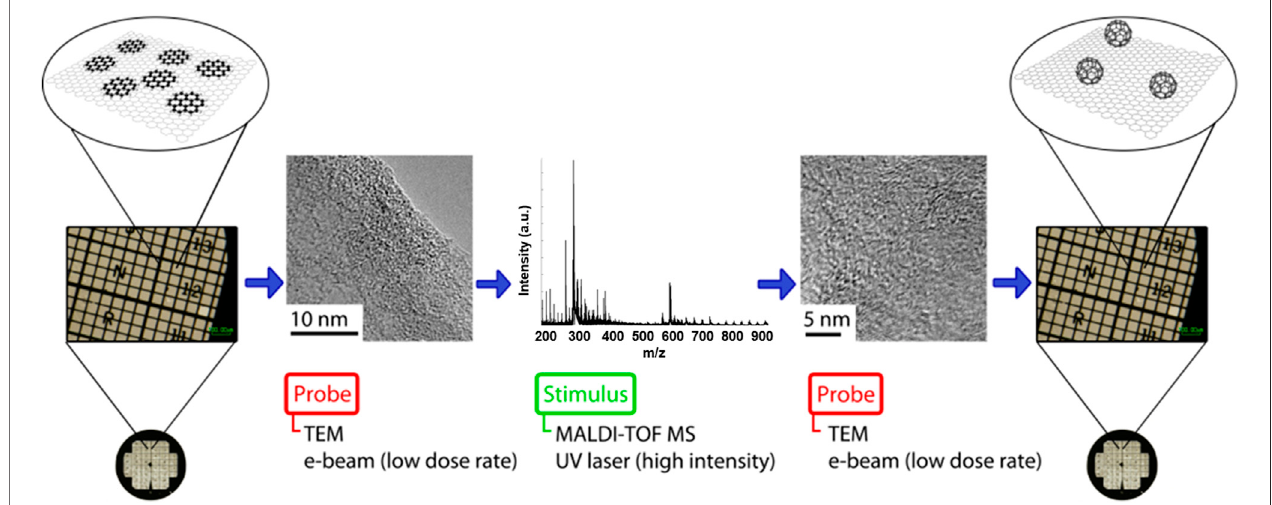
FIGURE 4 | Schematic illustration of the “ probe-stimulus-probe ” format in which an area of coronene deposited on a TEM grid is characterized using low-dose TEM, and then irradiated using the UV laser of MALDI-TOF MS to initiate transformations within the sample. Finally, the irradiated area is characterized again, using the locators on a TEM fi nder grid, to view the results of the induced transformations and determine the nature of any products formed.